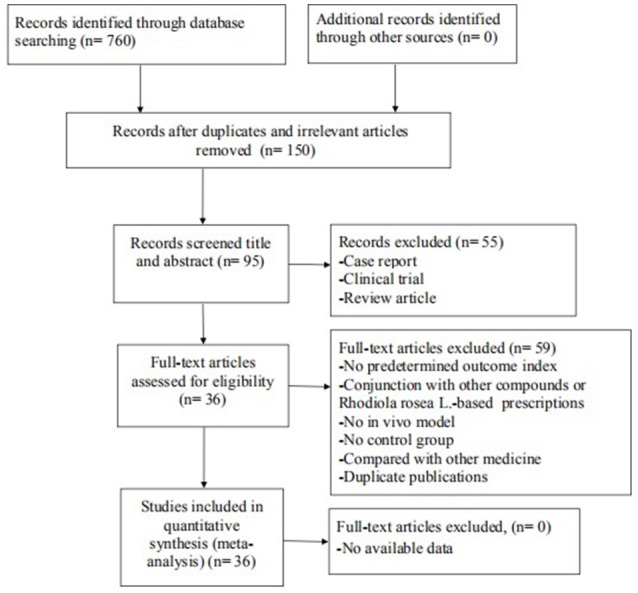
Summary of the process for identifying candidate studies.